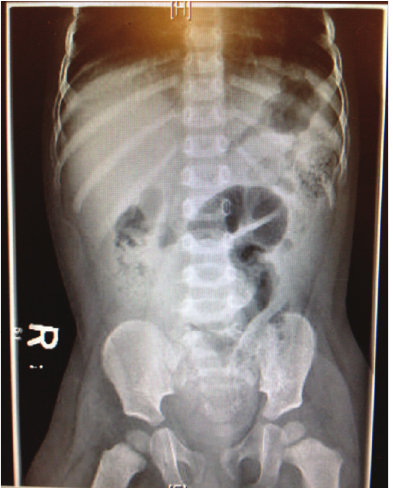
Figure 1: Supine abdominal plain film.